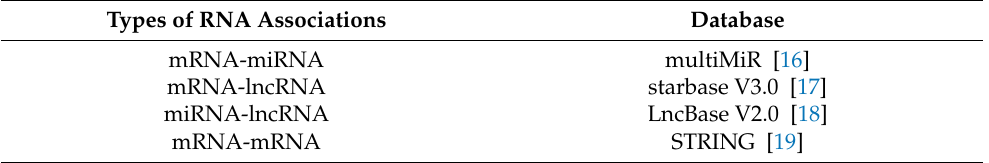
Table 1. RNA association and interaction database.